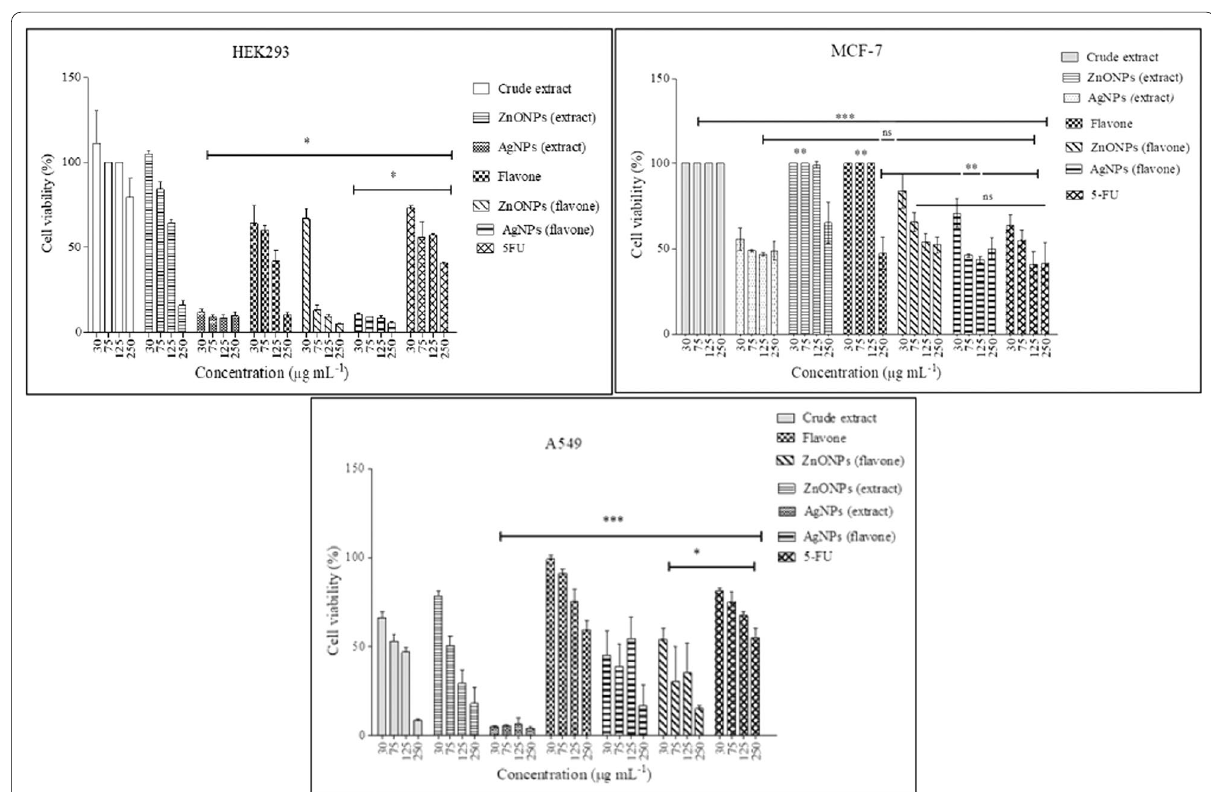
Fig. 7 MTT cell viability results for non-cancerous HEK293 and cancerous A549 and MCF-7 cell lines after treating with H. aureonitens extract, flavone, their nanoparticles (ZnONPs and AgNPs), and 5-fluorouracil, 5-FU. Significant differences (* p < 0.05, ** p < 0.005, *** p < 0.001) are relative to 5-FU